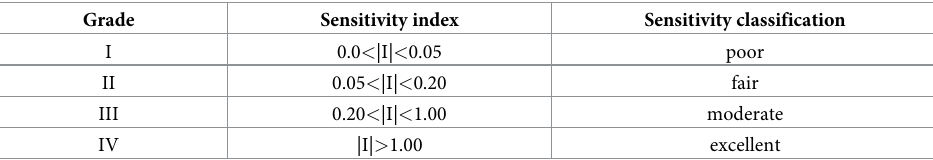
Table 2. Sensitivity classification.